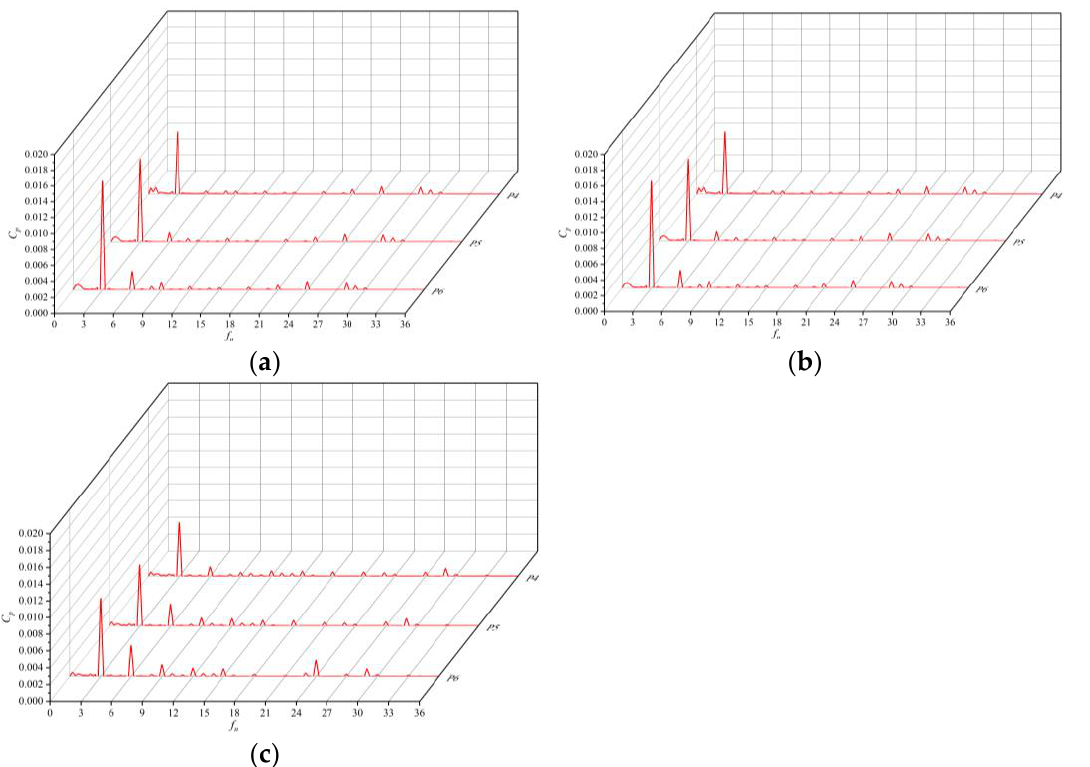
Figure 19. Frequency domain diagram of C p at impeller outlet: ( a ) Q = 0.8 Q bep ; ( b ) Q = 1.0 Q bep ; ( c ) Q = 1.2 Q bep .